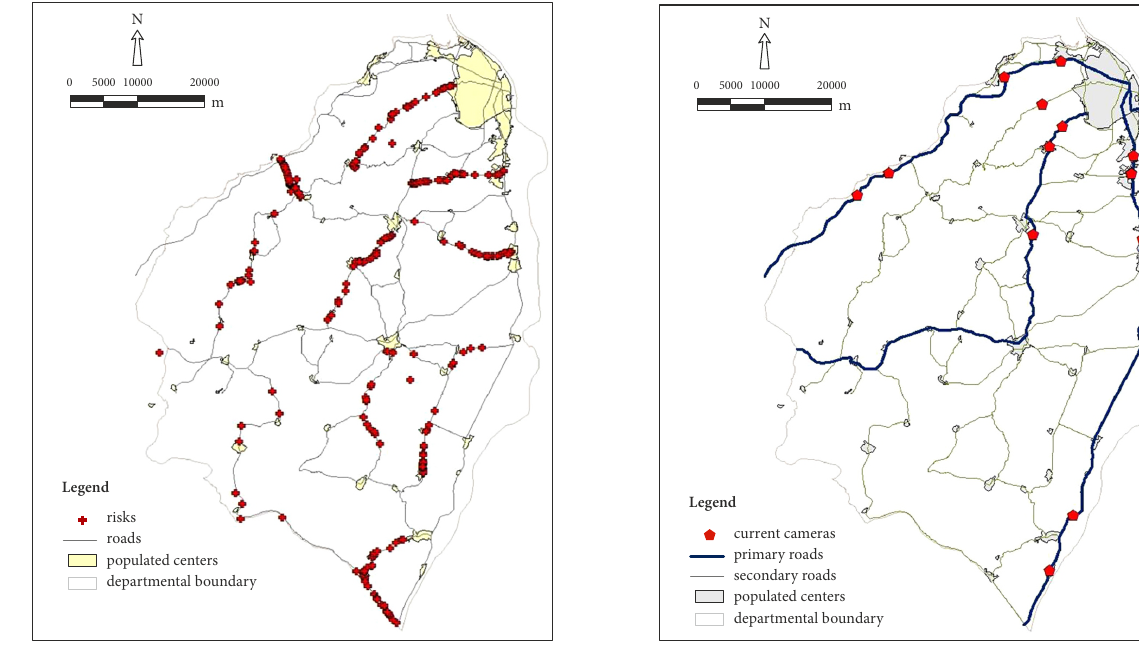
Figure 6. Location of risks Figure 7. Current location of